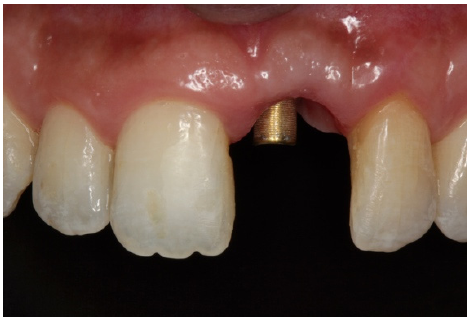
Figure 7. Prosthetic stage. Verification of the Zc coping on the abutment (Ti-Base ® BioHorizons Birmingham, AL, USA).